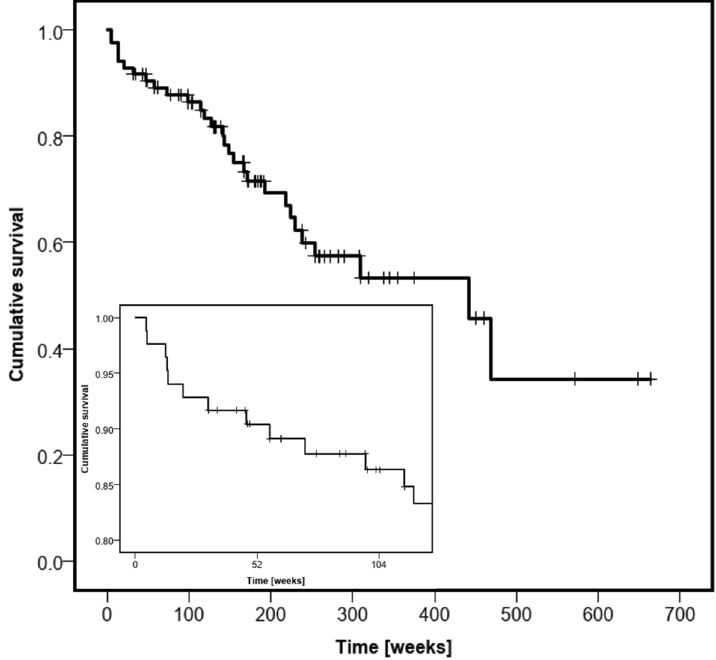
Figure 3. Kaplan–Meier survival analysis. Insert highlights survival in first 2 years of